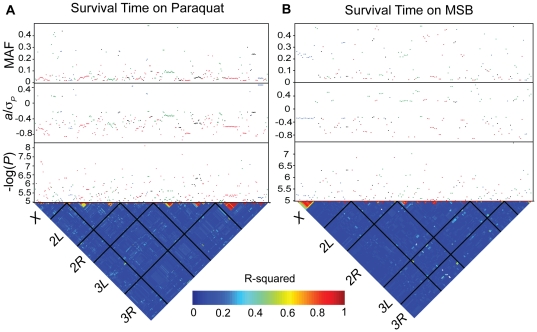
Genome-wide association analyses for survival time on paraquat and MSB (sexes pooled).All SNPs from single marker analyses with a nominal P<10−5 are shown. Associations based on females are depicted by red dots, males by blue dots, sexes pooled by black dots and SNP by sex interactions by green dots. The lower triangle depicts the degree of LD between SNPs as measured by r2, with the five major chromosome arms demarcated by the black lines. The heat map indicates the magnitude of LD with red corresponding to complete LD and blue to absence of LD. The upper panels show the significance threshold (−log10
P), the effect size in phenotypic standard deviation units (a/σP), and the minor allele frequency (MAF). (A) Survival time on paraquat. (B) Survival time on MSB.